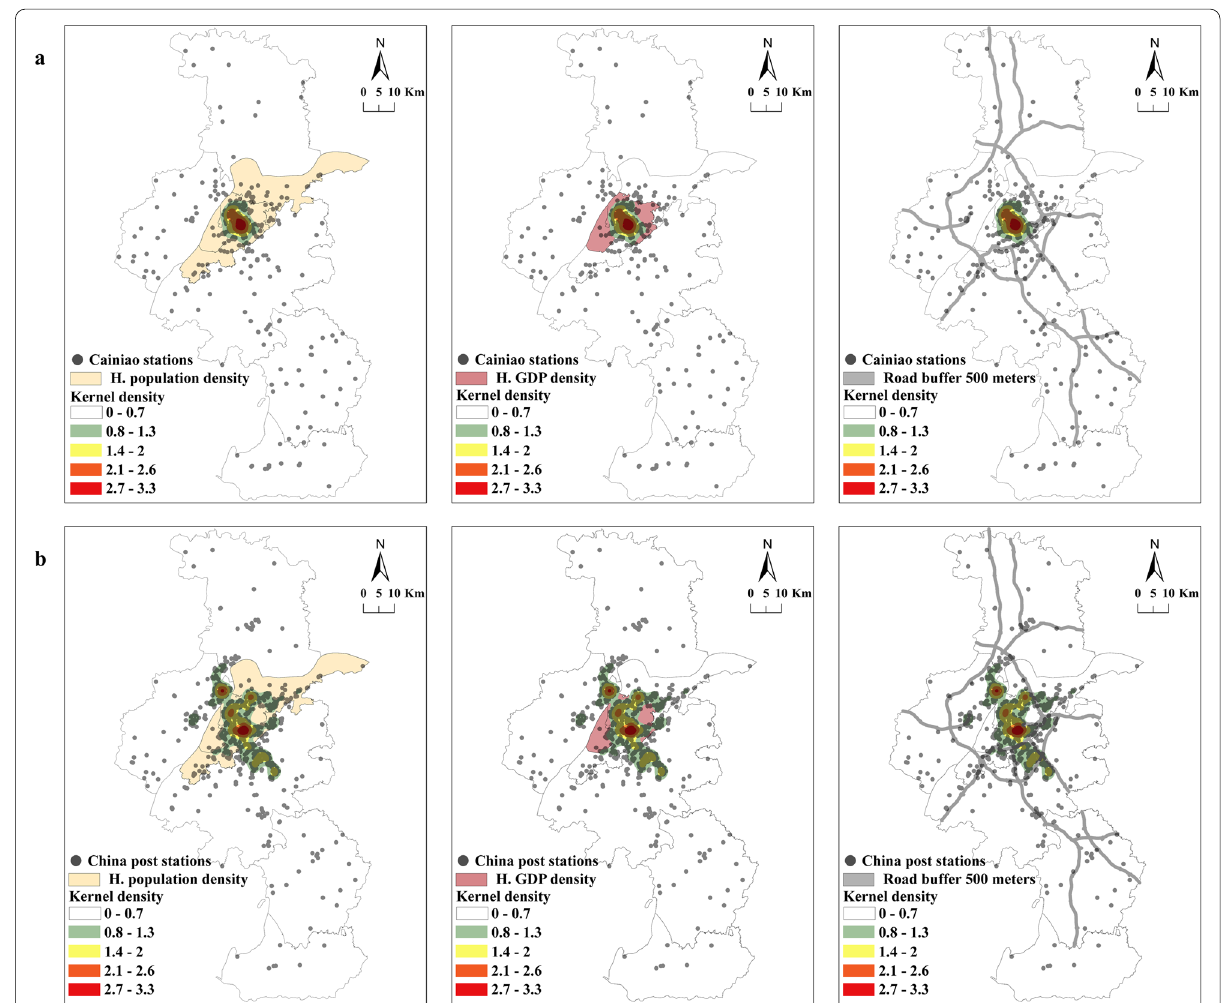
Fig. 5 Kernel density of CDPs and Getis-Ord Gi* cluster analysis (high population and GDP density areas with main roads 500-m buffer)